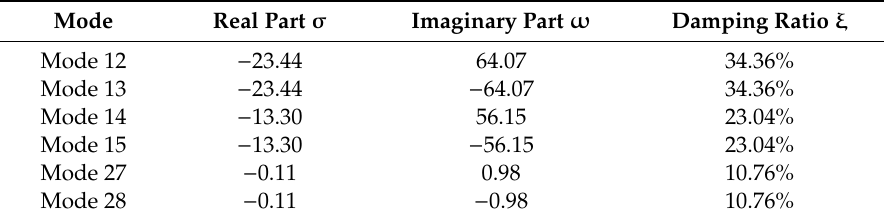
Table 5. Oscillatory modes, operating point 1, SVC connected.